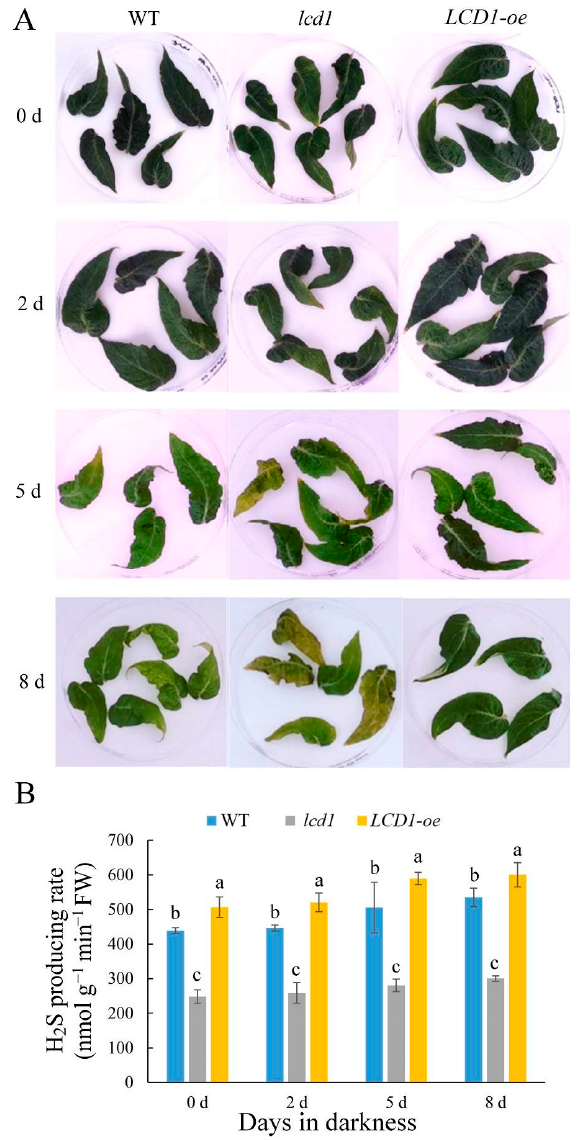
Figure 2. ( A ) Dark-induced senescence symptoms in detached leaves of 6-week-old wild-type (WT), lcd1 , and LCD1-oe tomatoes for up to 8 days. ( B ) H 2 S producing rate in detached leaves of 6-week- old wild-type (WT), lcd1 , and LCD1-oe tomatoes stored in darkness for up to 8 days. Different letters above the columns stand for significant difference between two values ( p < 0.05) at the same time point.